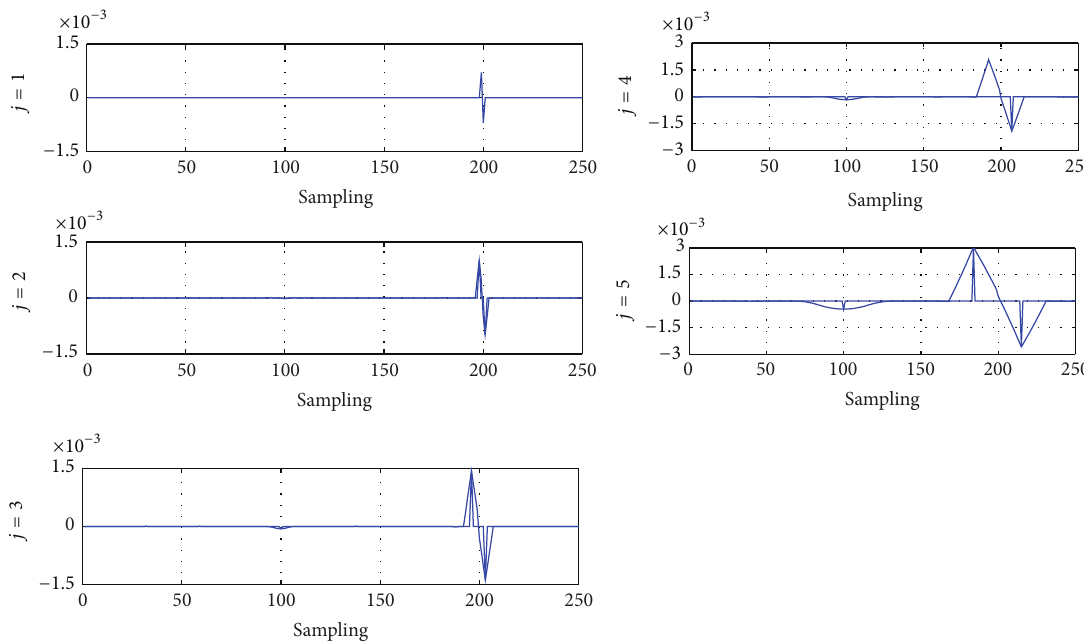
Figure 5: Slope error detection by binary wavelet transform.